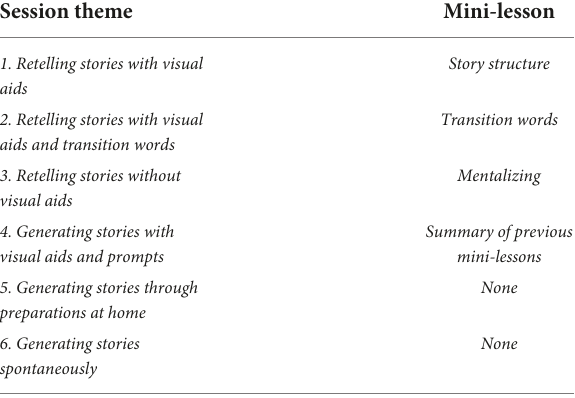
session. For each session, an extensive manual was written